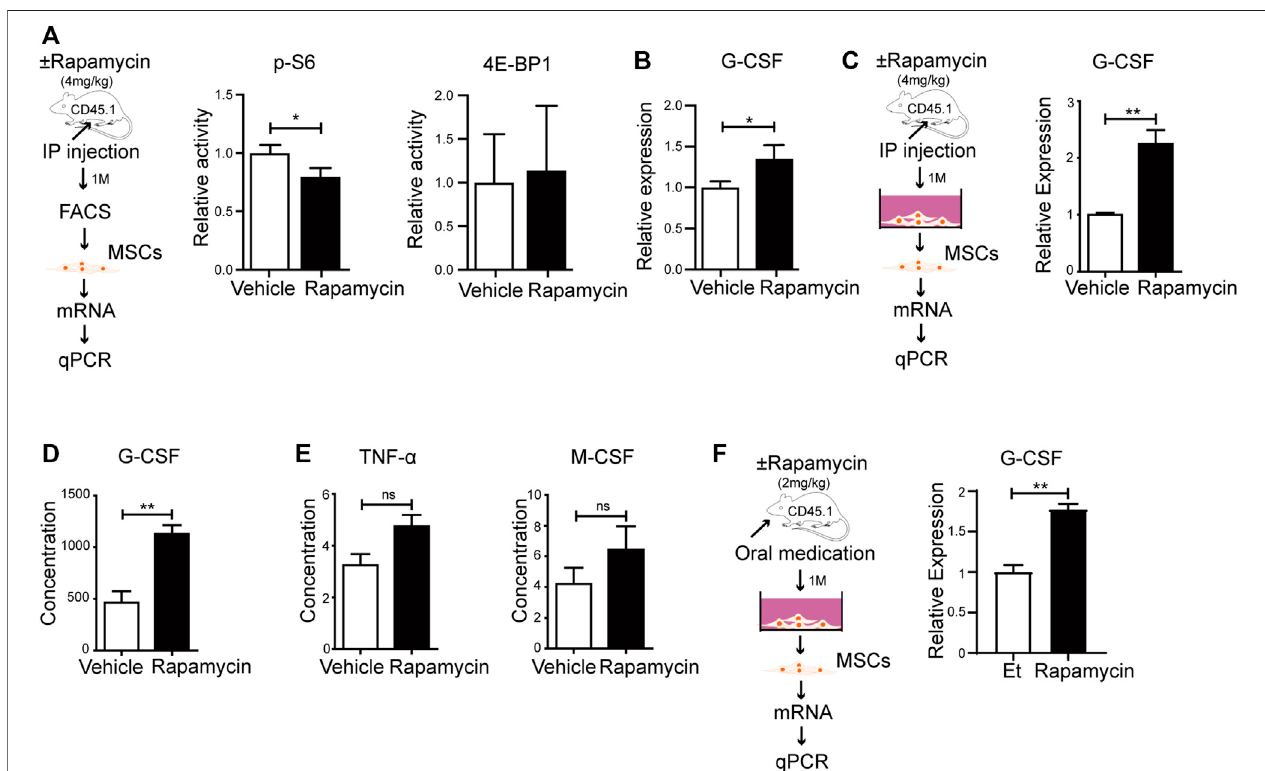
FIGURE6| Rapamycin prompted MSCstoproduce more G-CSF invivo (A) Experiment design ofMSCsisolated frommicetreatedwithrapamycinor vehicle byi. p., n = 3, days = 30, dose = 4 mg/kg/day (left panel). Fluorescence intensity of p-S6 and p-4E-BP1 in MSCs treated by rapamycin or vehicle by i. p (right and middle panels) (B) mRNA relative expression of G-CSF in MSCs from mice treated with rapamycin or vehicle by i. p. (C) Experiment design of MSCs cultured in vitro (left panel). mRNA relative expression of G-CSF in MSCs after culture (right panel) (D – E) Relative expression of G-CSF 、 TNF- α and M-CSF in serum from mice treated with rapamycin or vehicle by Milliplex multifactor detection technology (F) Experiment design of MSCs isolated from mice treated with rapamycin or ethanol by p. o., n = 3, days = 30, dose = 2 mg/kg/day (left panel). Relative mRNA expression of G-CSF in MSCs of two groups (right panel).